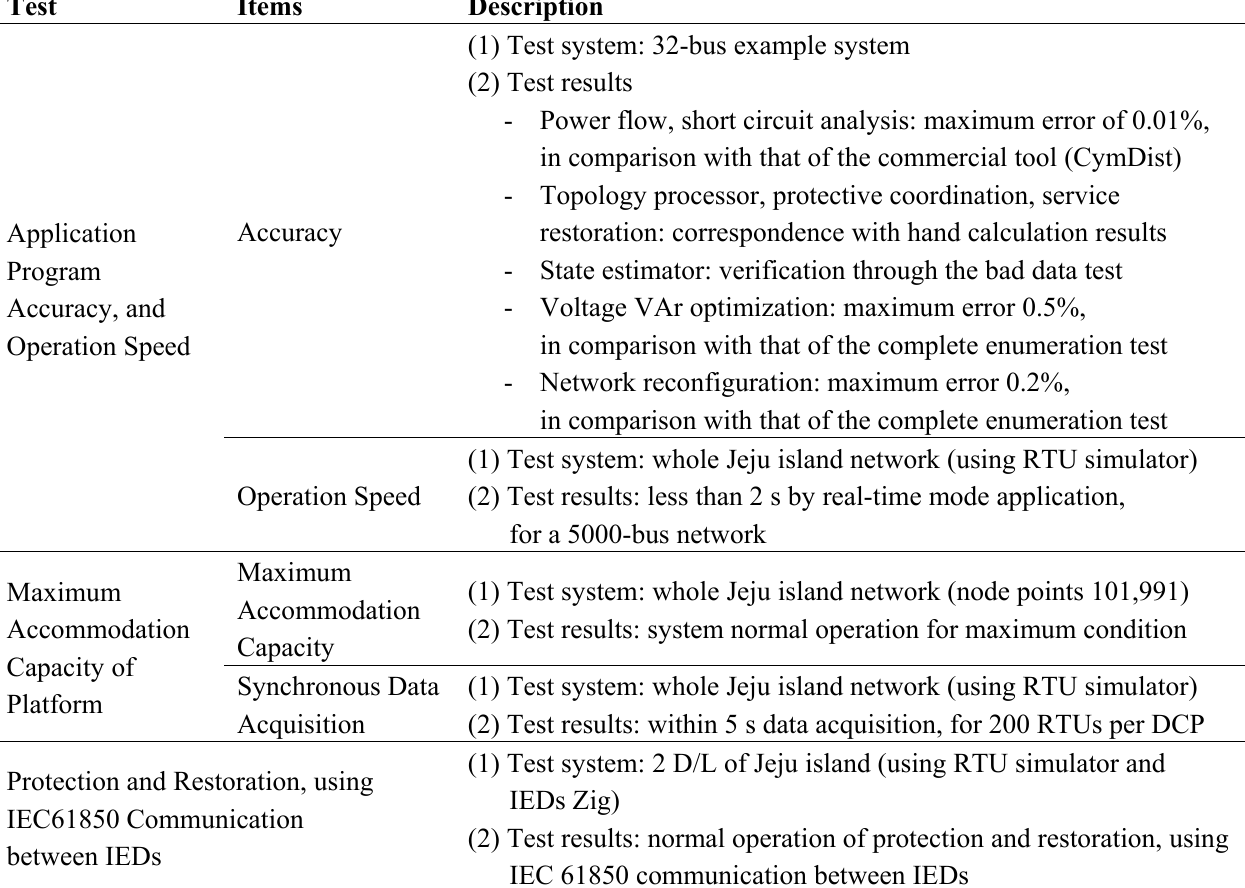
Table 9. Results of the functional and integration